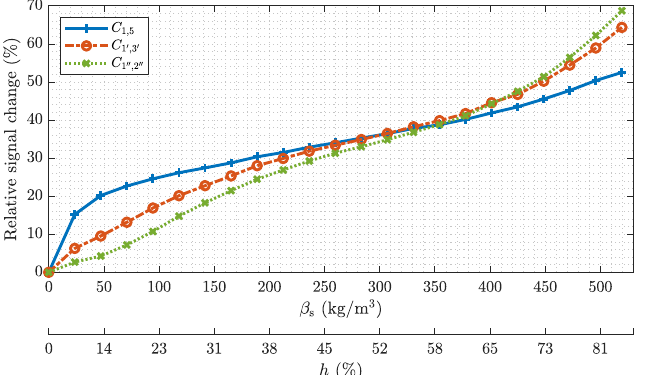
Figure 10. Relationship between the relative signal change off the measured capacitances and the mass concentration within the sensor. Additionally, the corresponding filling height h of the material holder is